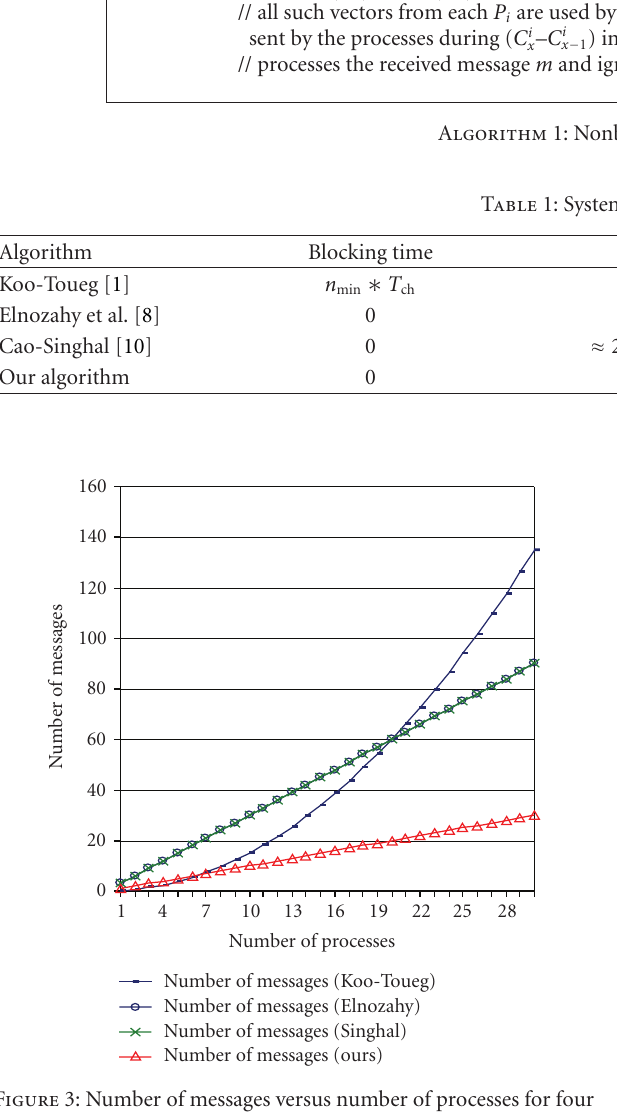
Figure 3: Number of messages versus number of processes for four di ff erent